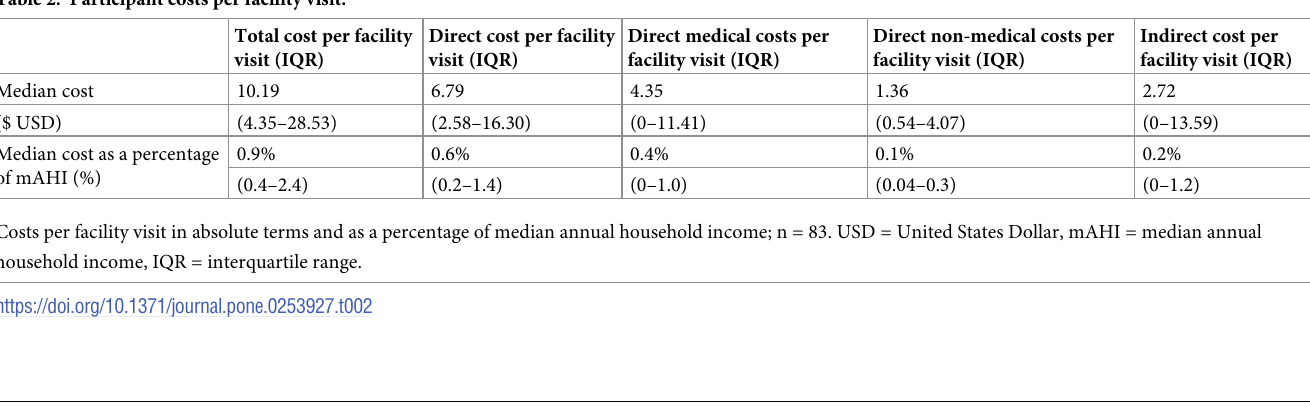
Fig 3. Patient pathways to care after TB evaluation. Flowchart showing patient pathways to care after TB evaluation. To the right of each facility visit, coloured boxes represent the types of facilities participants visited (see Key). Numbers within the boxes represent the number of participants visiting that type of facility. Blank boxes indicate that facility type was not visited. If a participant visited a further facility, their next visit is recorded at the next step of the flow chart. If a participant did not visit a further facility, they exit the flow chart to the left of their current facility visit. CHW = Community Health Worker.